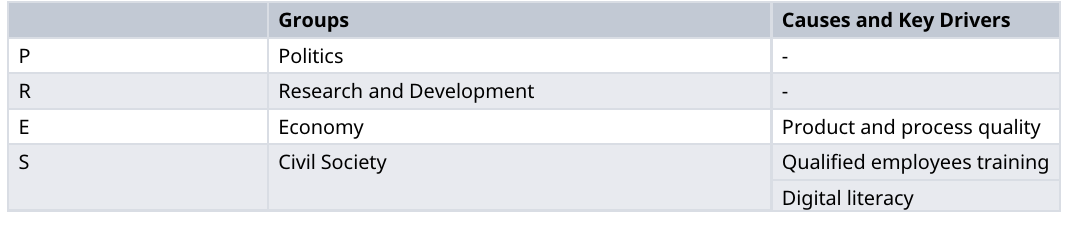
Table 5. Groups of stakeholders and indicators with assigned causes and drivers according to Katz et al.